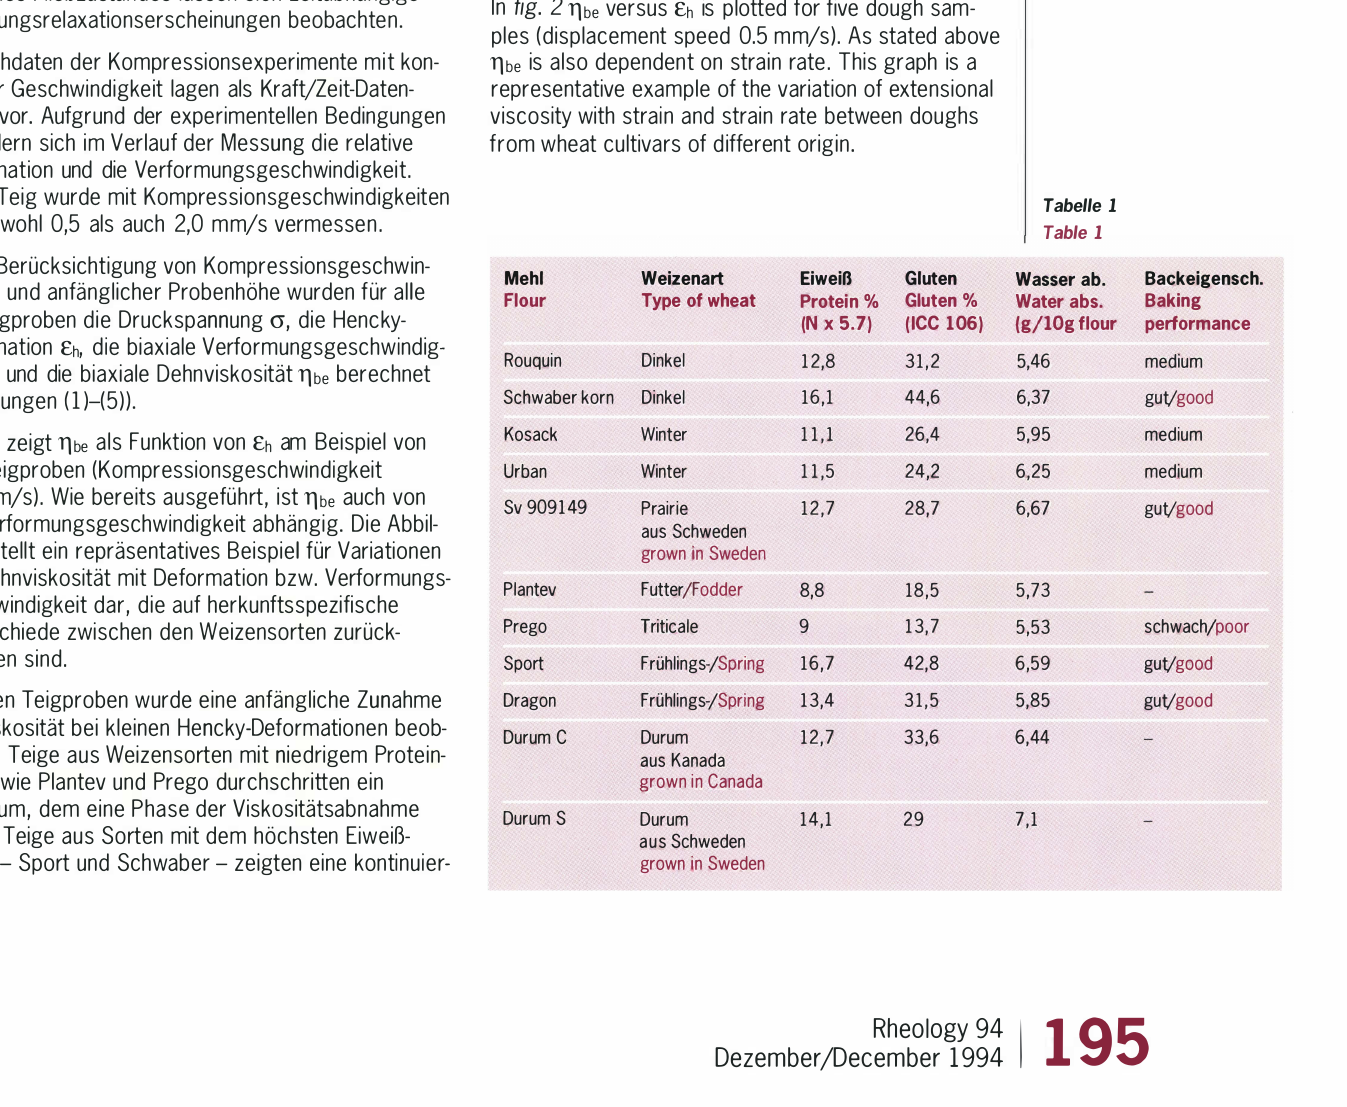
4 Results and Discussion Dough behaves as a non-linear viscoelastic material in that its flow properties are dependent on the strain as well as the strain rate. After cessation of the flow a time-dependent stress relaxation is observed. The original data obtained from the compression experiments were force versus time using constant displacement speed of the upper plate. Because of the nature of the experiment both the strain and the strain rate varied during the course of the measure­ ment. The same set of measurmeents were performed at each of two displacement speeds, 0.5 and 2.0mm/s. Taking the displacement speed and the original height of the sample into account, the stress cr, Hencky strain fh, the biaxial strain rate Eb , and the biaxial viscosity llbe were calculated (eqns. (1)-(5)) for the eleven dough samples. In fig. 2 llbe versus fh is plotted for five dough sam­ ples (displacement speed 0.5 mm/s). As stated above llbe is also dependent on strain rate. This graph is a representative example of the variation of extensional viscosity with strain and strain rate between doughs from wheat cultivars of different origin.